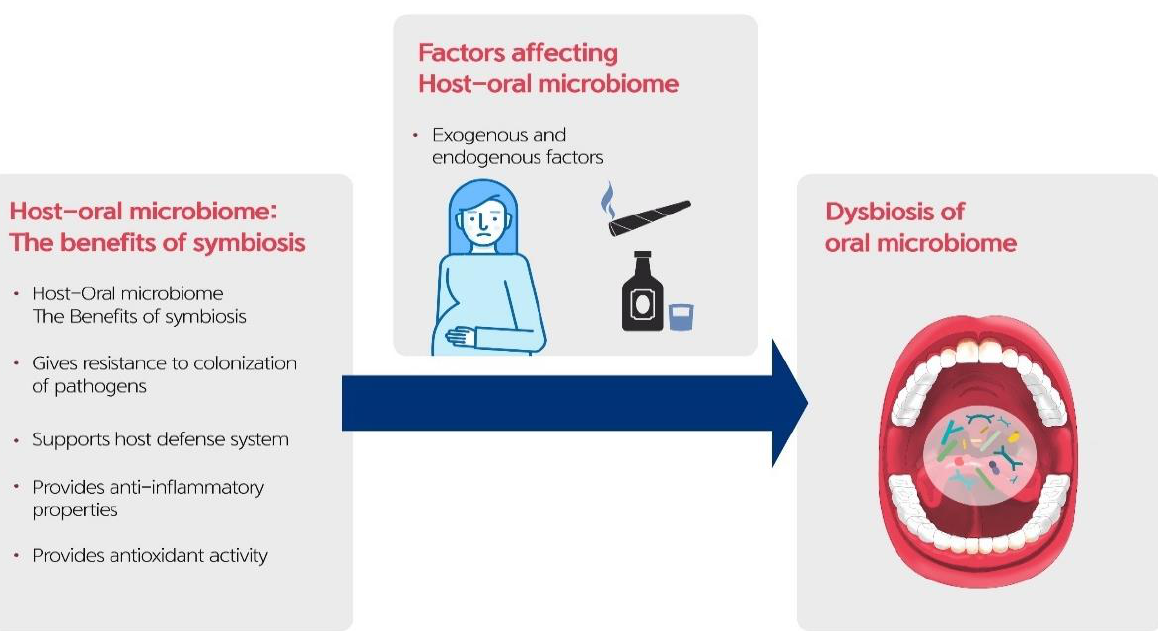
Figure 3. Various factors affecting the oral microbiome.